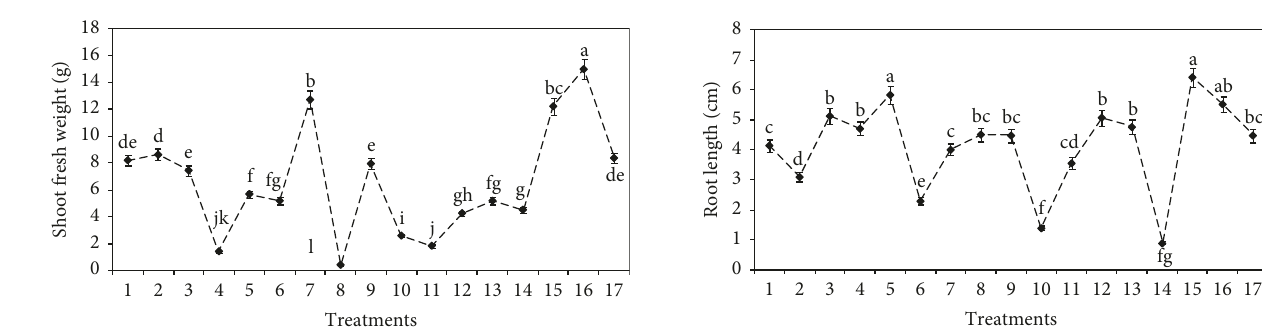
Figure 5: Impact of biosorbed water by various biosorbents (or- ange peels, pomegranate peels, and peanut peels) on the shoot fresh weight of mung bean after 7 days of seed germination. T1 negative control; T2, 50mg kg − 1 ; T3, pomegranate peel biosorbed water +50mg kg − 1 ; T4, peanut peel biosorbed water +50mg kg − 1 ; T5, orange peel biosorbed water +50mg kg − 1 ; T6, 100mg kg − 1 ; T7, pomegranate peel biosorbed water +100 mg kg − 1 ; T8, peanut peel biosorbed water +100mg kg − 1 ; T9, orange peel biosorbed water +100 mg kg − 1 ; T10, 150mg kg − 1 ; T11, pomegranate peel biosorbed water +150 mg kg − 1 ; T12, peanut peel biosorbed water +150 mg kg − 1 ; T13, orange peel biosorbed water +150 mg kg − 1 ; T14, 200mg kg − 1 ; T15, pomegranate peel biosorbed water +200mg kg − 1 ; T16, peanut peel biosorbed water +200 mg kg − 1 ; T17, orange peel biosorbed water +200mg kg − 1 Vertical bars (I): standard error (mean of 3 replicates). Alphabets on vertical bars: significant difference ( P ≤ 0 . 05) evaluated by the LSD test.